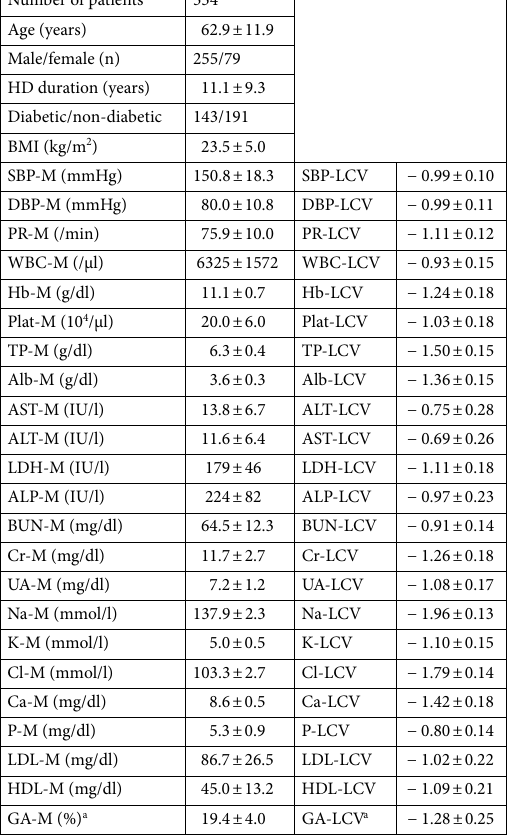
Table 1. Characteristics of the study population. HD hemodialysis, BMI body mass index. The age and HD duration indicated represent the values as on the first day of the data collection period (January 1, 2020). X-M denotes the annual mean of biomarker X, and X-LCV represents its variability (log-transformed coefficient of variation) calculated from the one-year measurements. Values are means ± SD of the population. a For GA-M and GA-LCV, the values are calculated for diabetic subjects